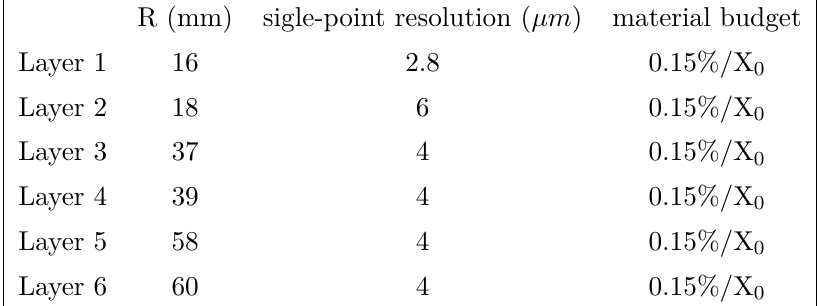
Table 4 . The baseline design parameters of the CEPC vertex system.